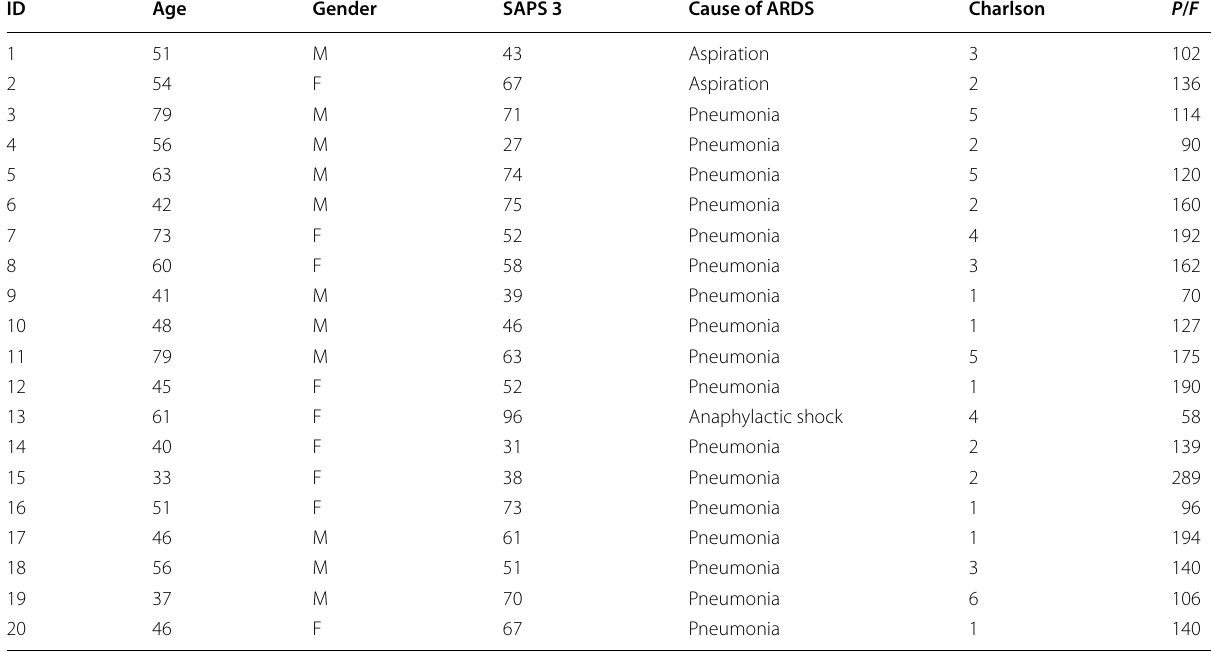
Table 1 Patient demographics at admission and at diagnosis of ARDS